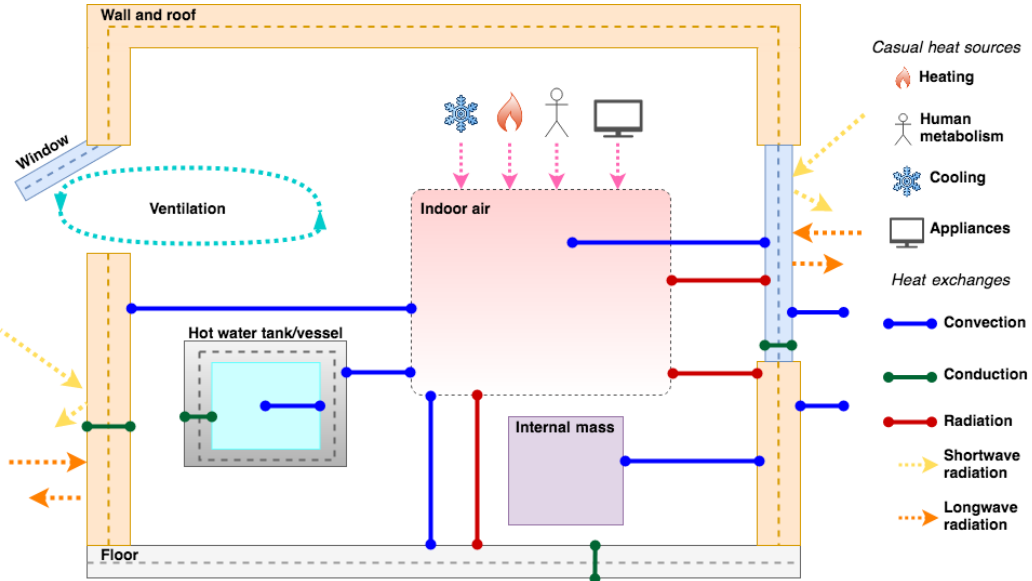
Figure B1. STEBBS 1-D model simulates building facets and nodes (dots), casual heat sources, and heat exchanges. Longwave radiation is absorbed by building facets from the outdoor environment and shortwave radiation from direct, diffuse, and reflected sources.